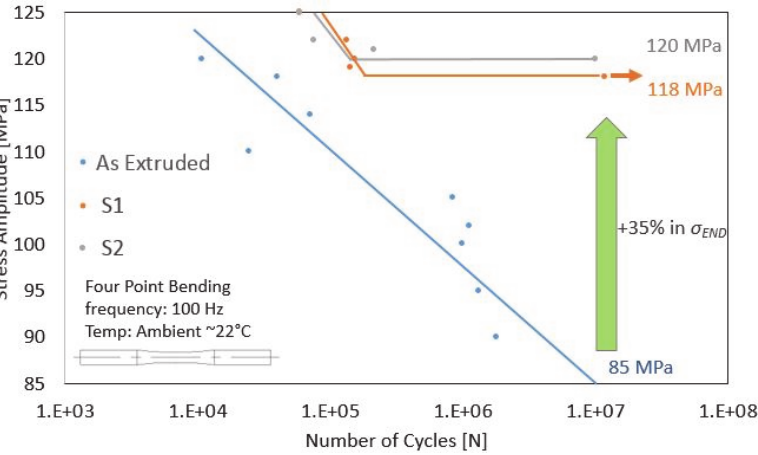
Figure 5: Fatigue life of forged AZ31B extruded magnesium alloy in comparison with the AZ31 extruded base alloy, obtained at total stress amplitudes of 90-125 MPa. Points with arrow show run-out tests.